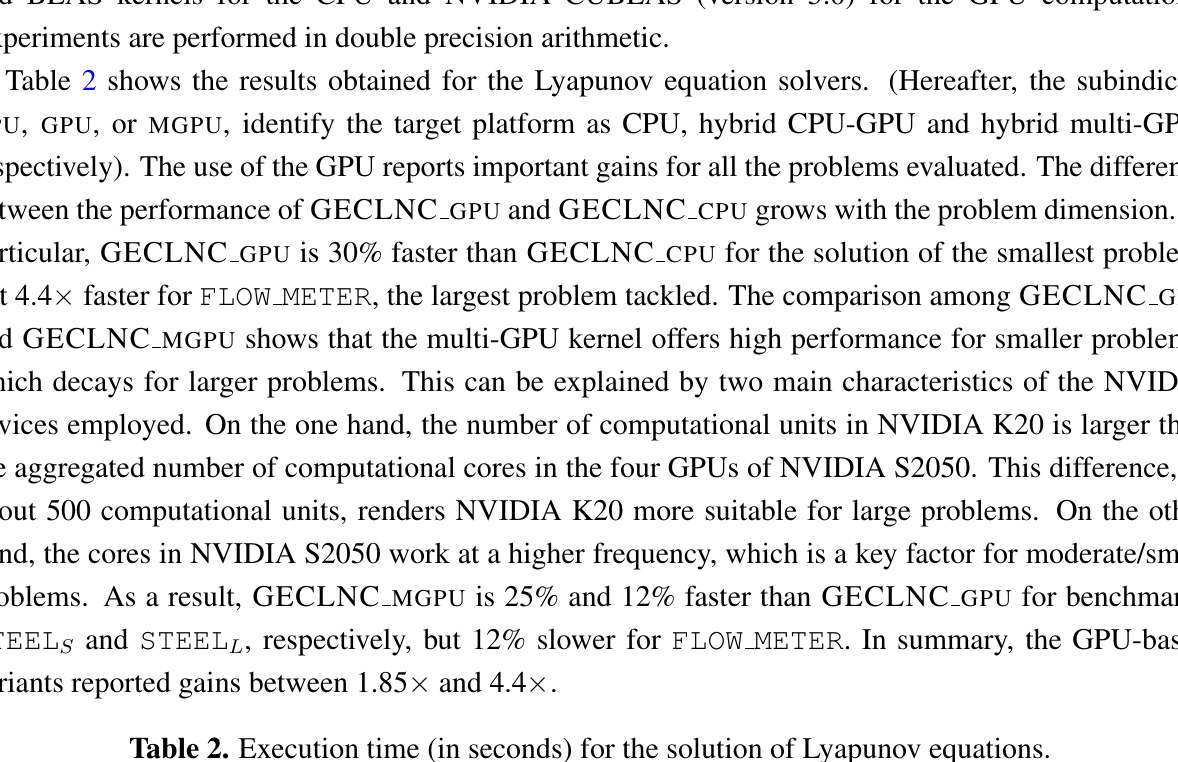
Table 2. Execution time (in seconds) for the solution of Lyapunov